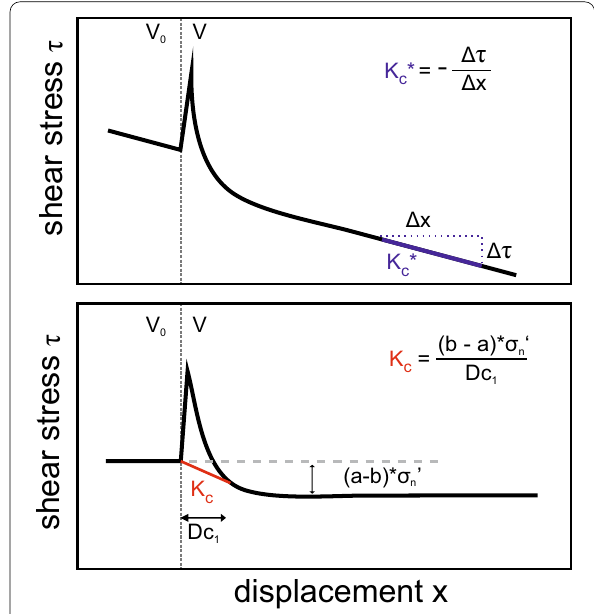
Fig. 5 Concept of critical stiffness. Schematic diagram showing a velocity step at low effective normal stress. A Determination of the critical stiffness for slip instability based friction slip dependence (Ikari et al. 2013). B Determination of the critical stiffness criterion based on RSF parameters derived from inverse modeling, including a linear detrending algorithm (Blanpied et al. 1998; Ruina 1983)